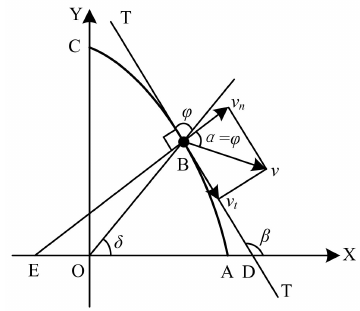
Figure 5. The analysis of the cutting edge curve of the moving cutter. Note: T–T is the tangent line to point B; EB is the normal line at point B; OB is the rotation radius of point B, mm; v is the sliding cutting speed at point B, m/s; v t is the tangential velocity at point B, m/s; and v n is the normal velocity at point B,